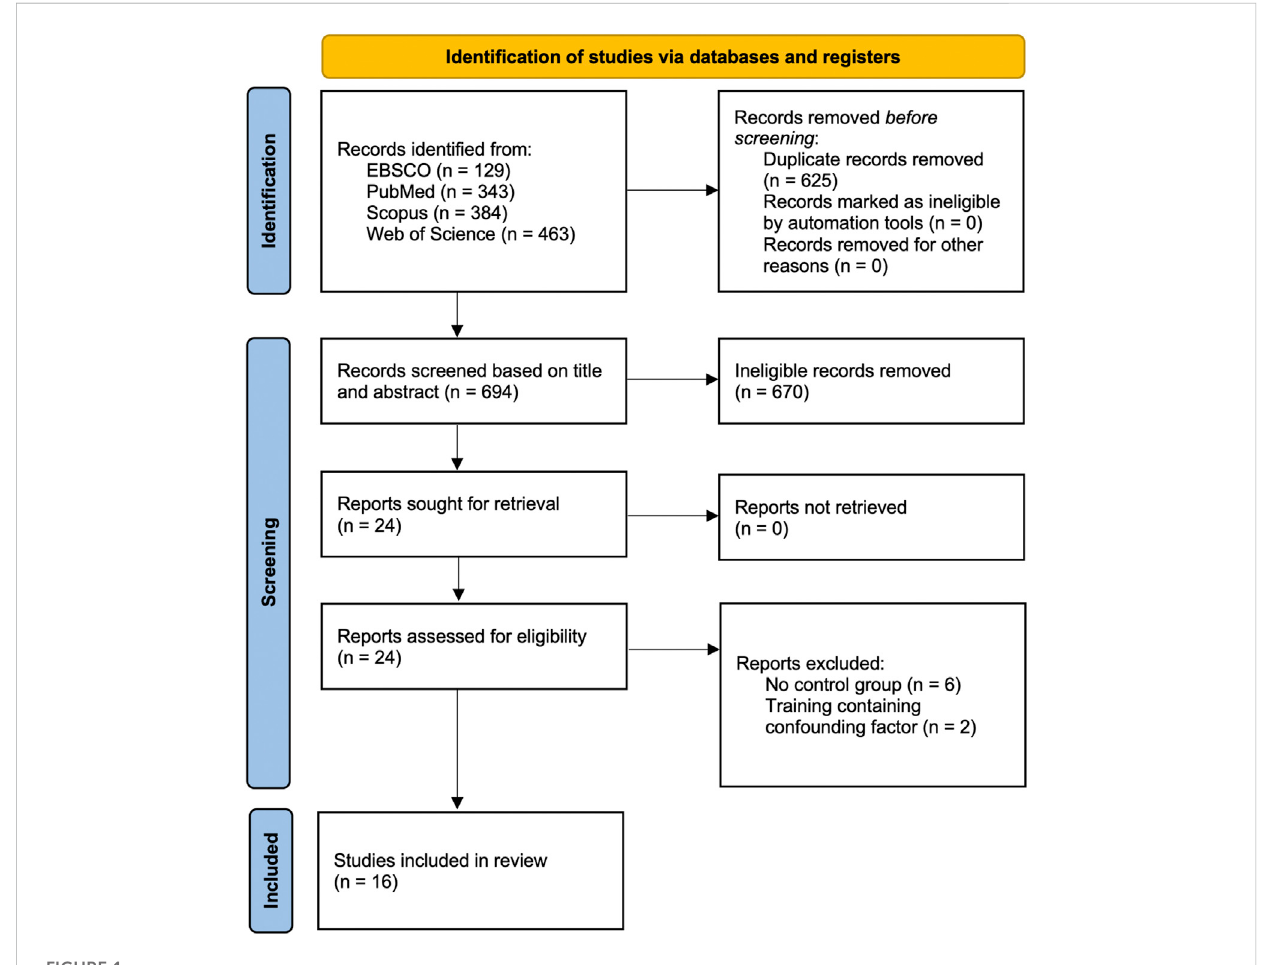
FIGURE 1 Flow chart of study